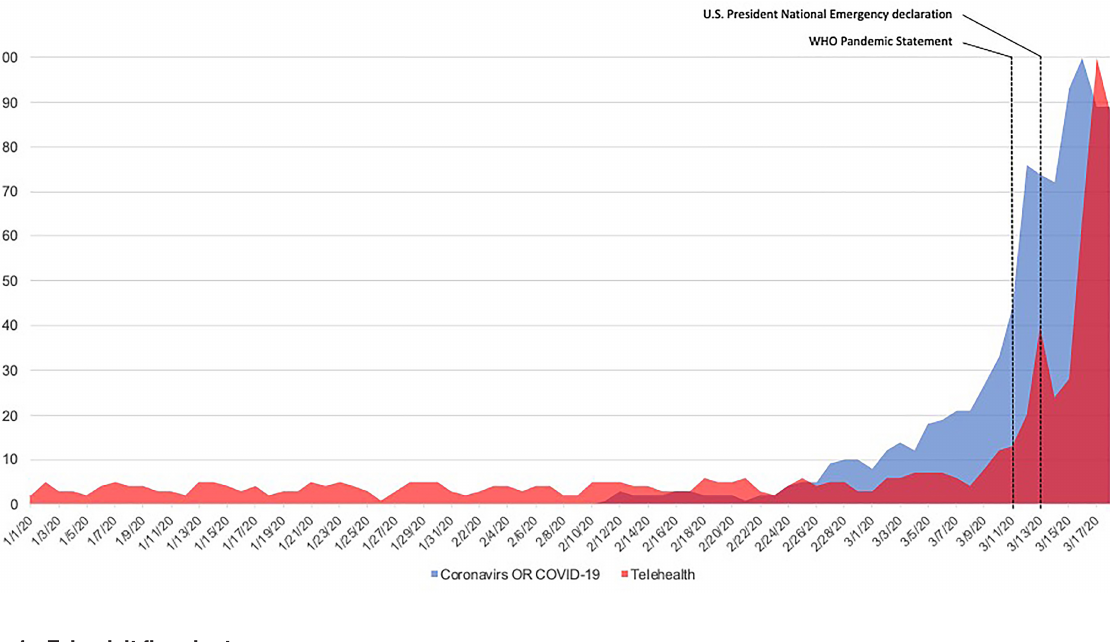
Table 1 - Tele-visit